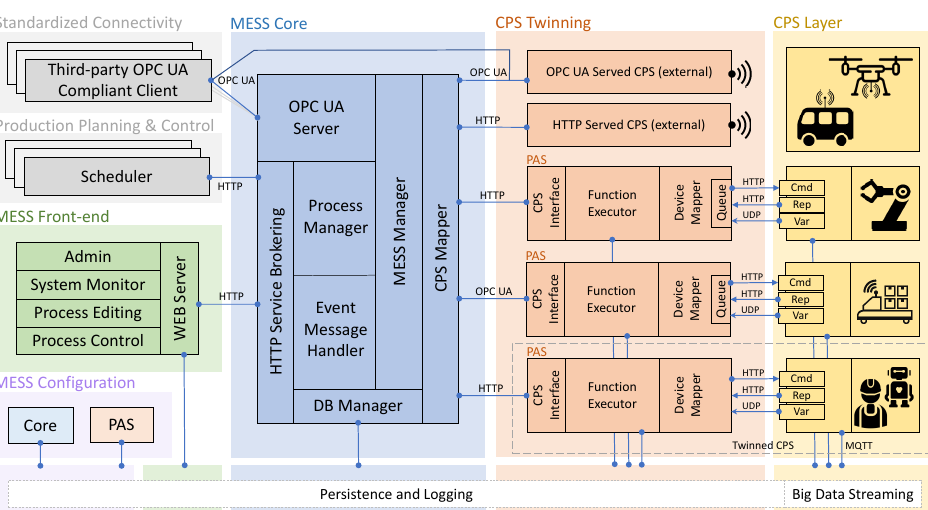
Figure 4. Overall view of the MESS